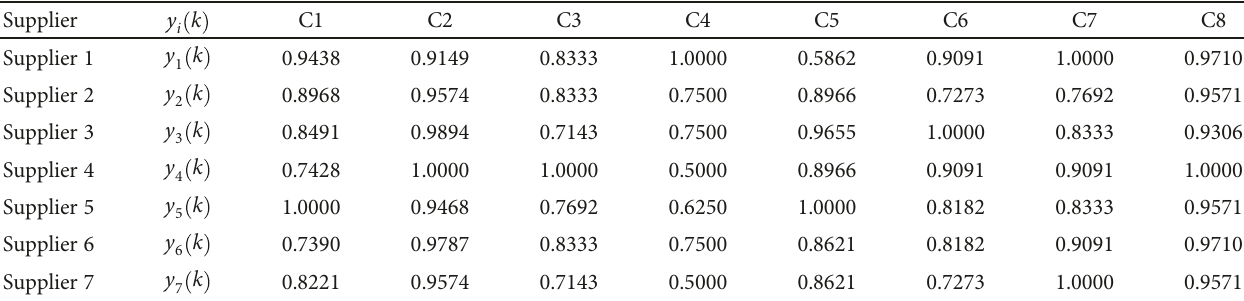
Table 3: Normalized